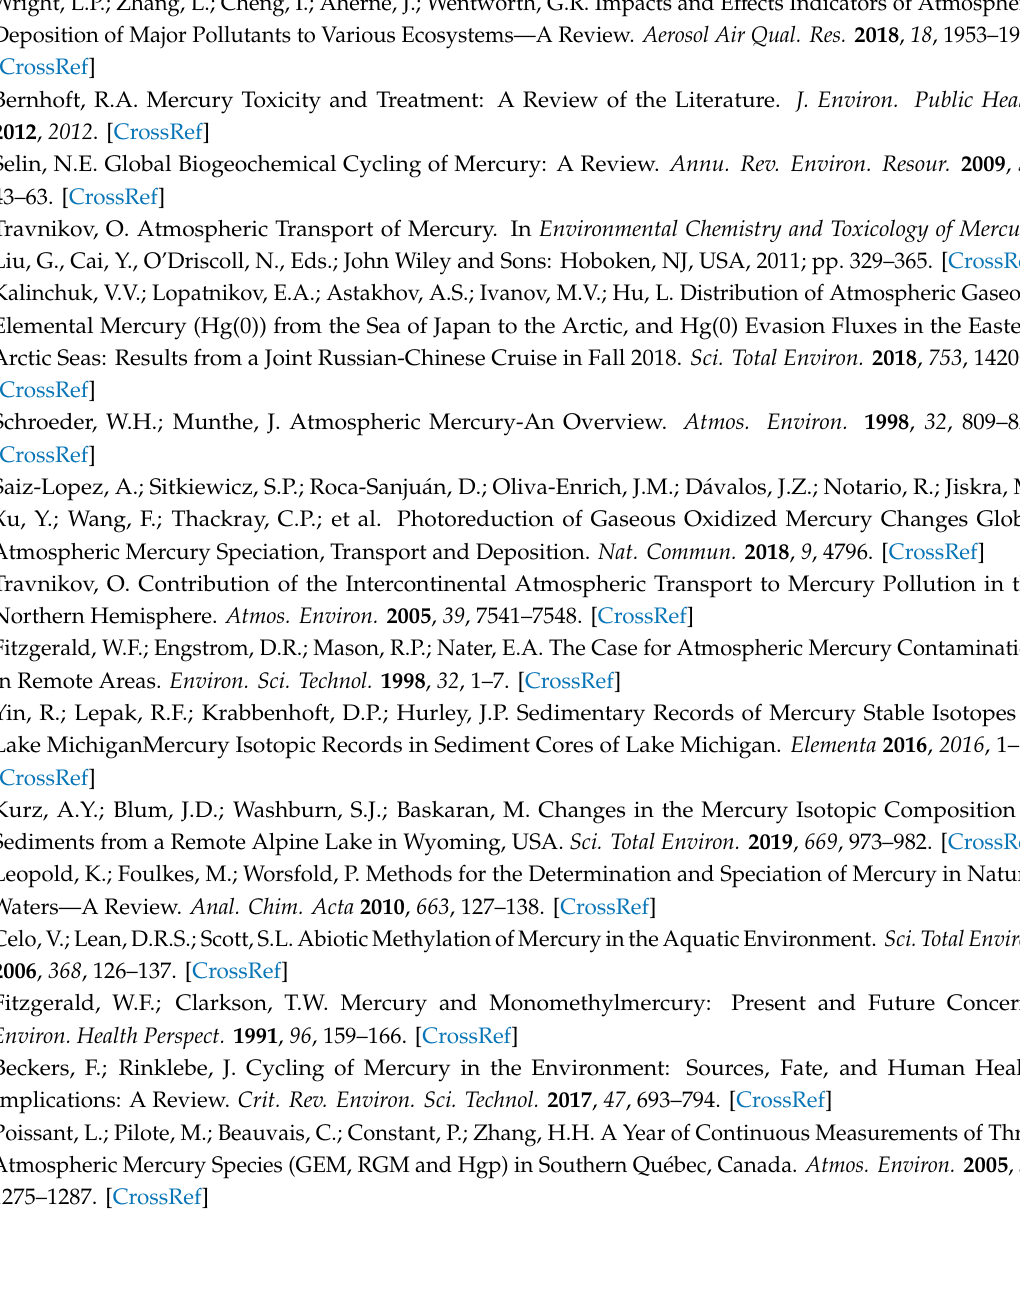
Table S1: Basic univariate statistic of gaseous elemental mercury (GEM) dataset and wind and air temperature data during sampling periods. Meteorological data are given as hourly averages. Siap / MICROS: OSMER-ARPA FVG meteorological network, CAE: Protezione Civile FVG monitoring